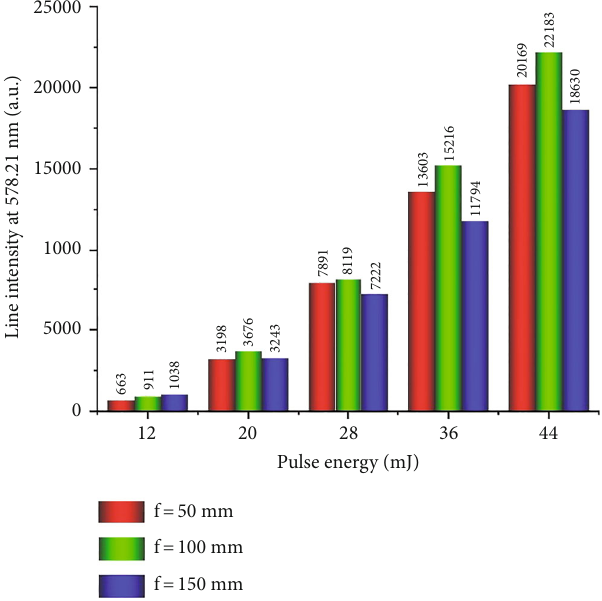
Figure 6: Maximum spectral intensity of Cu(I) at 578.21nm for various pulse